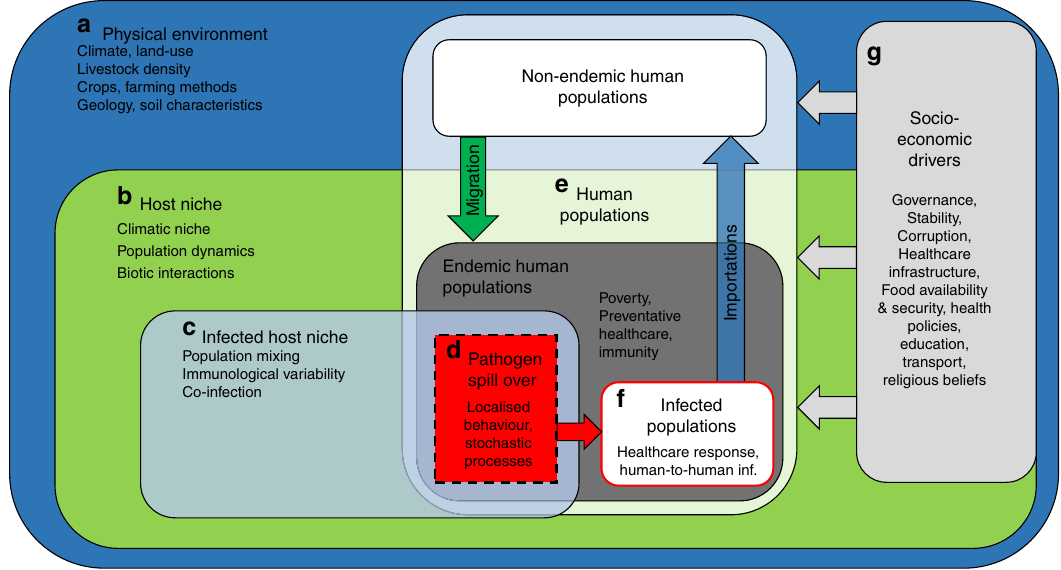
Fig. 1 System-dynamics model of zoonotic disease transmission. Letters a – f indicate major system components, arrows showing links, and key sub- components in smaller font. Within the global physical environment ( a ), both the host niche ( b ) and infected host niche ( c ) are nested subsets, which all vary over a relatively slow time-scale. Endemic human populations are nested within the global human population ( e ), with human socio-economic factors ( g ) affecting all human populations. Spill-overs happen in the fast-moving spatial and temporal interface of these two nested systems ( d ), where both infected hosts, susceptible people and spill-over speci fi c factors occur, resulting in infected human populations ( f